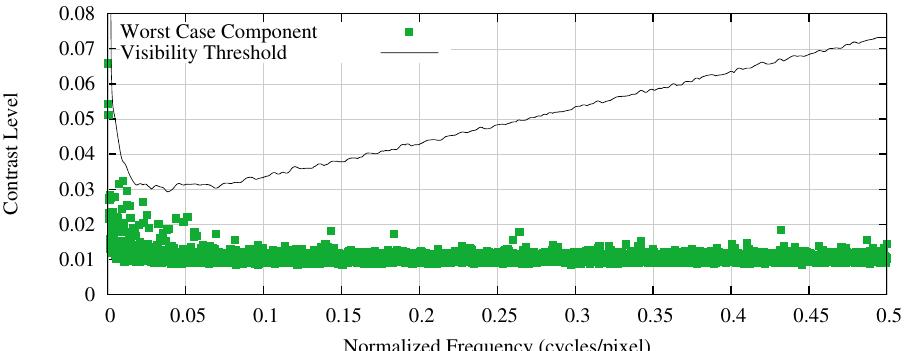
Figure 3. Worst case frequency domain components for the cirrus band, band 9, using multiple 60 s shutter and solar diffuser collects. All components are below the 80% confidence level for CN visibility. The contrast level is the frequency domain noise amplitude normalized to the dynamic range of the given collect (in this case the dynamic range is the 3 σ noise